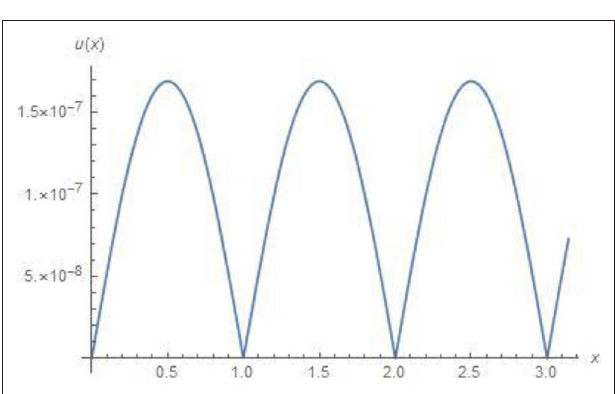
FIGURE 8 | Absolute error for TFPPDE (29) at α